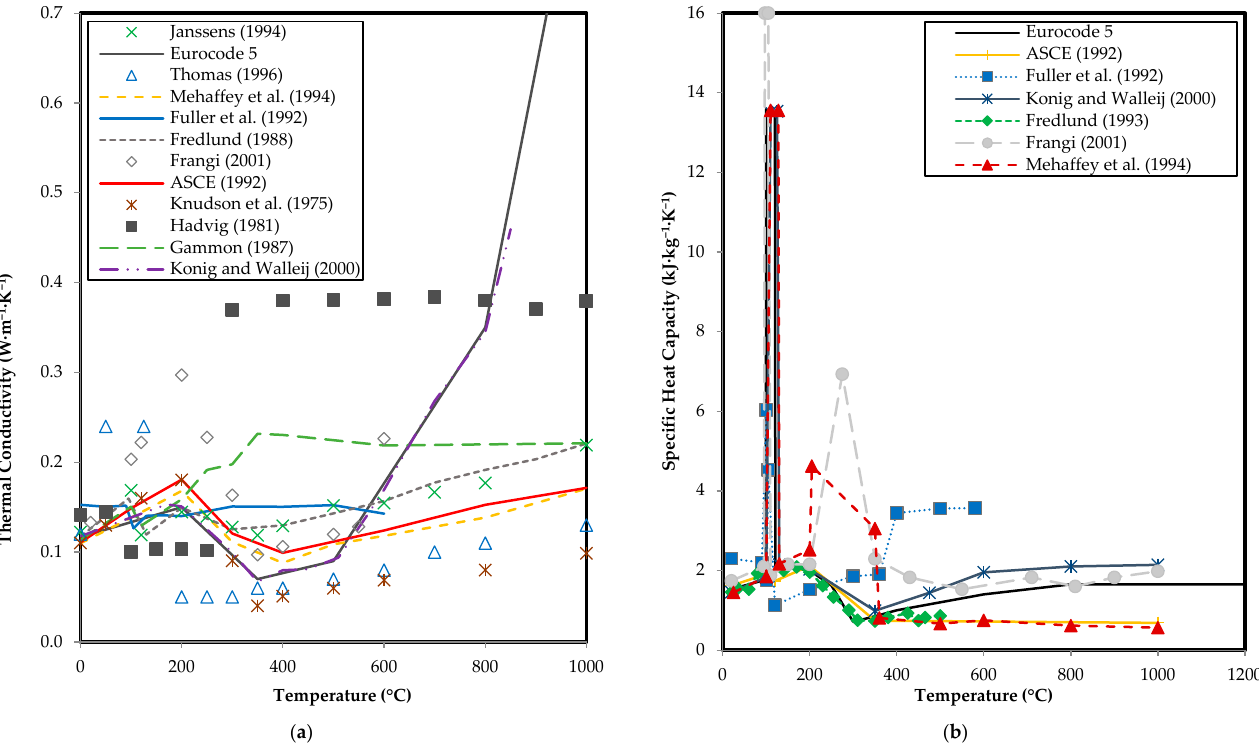
Figure 1. Properties of wood: ( a ) dependence of thermal conductivity of wood on temperature; ( b ) dependence of specific heat capacity of wood on temperature.